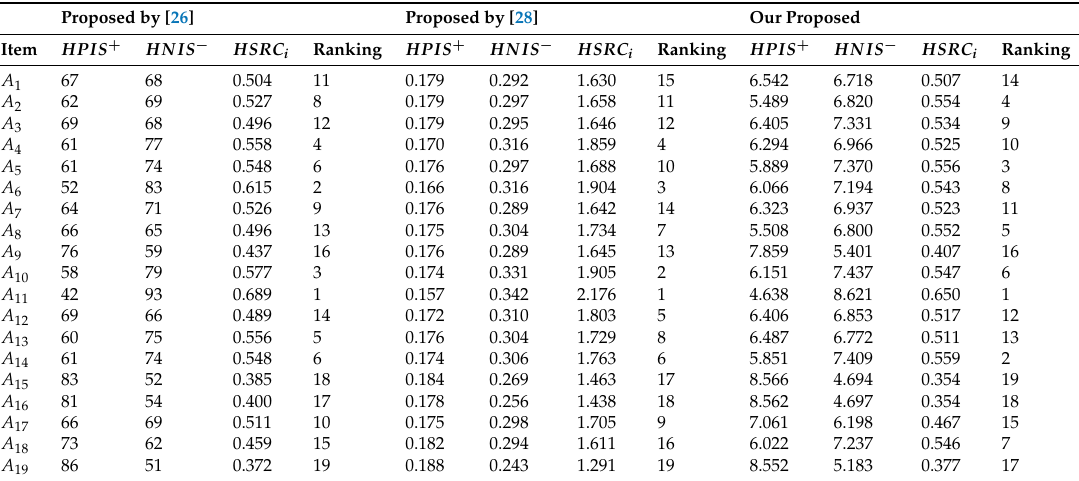
Table 7. Comparisons of the closeness ( HSRC i )